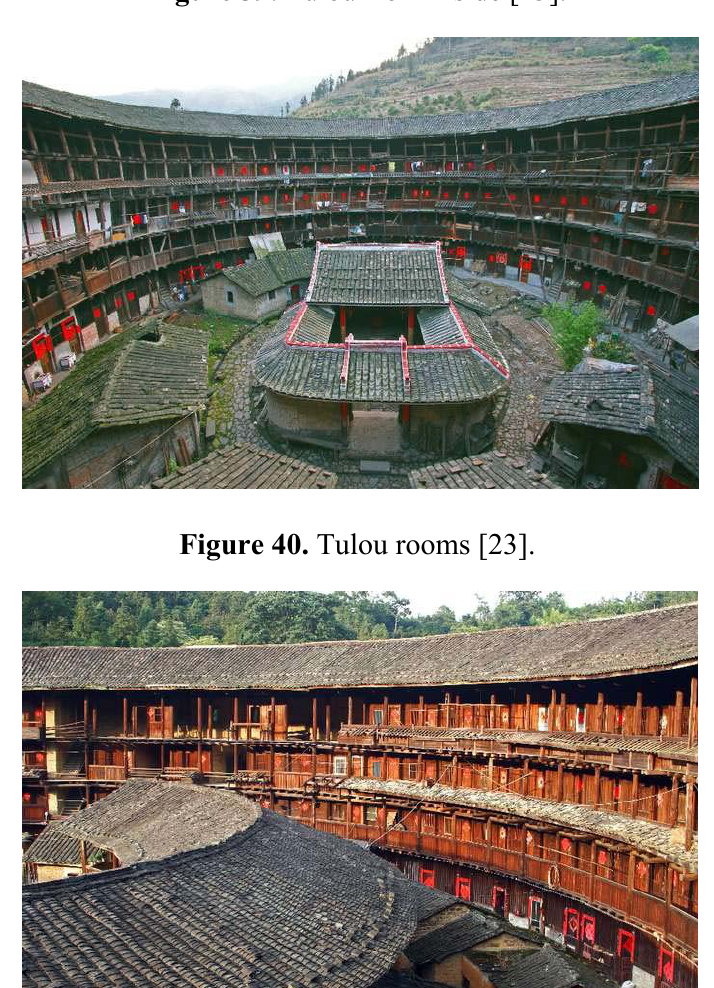
Figure 39. Tulou from inside [23].